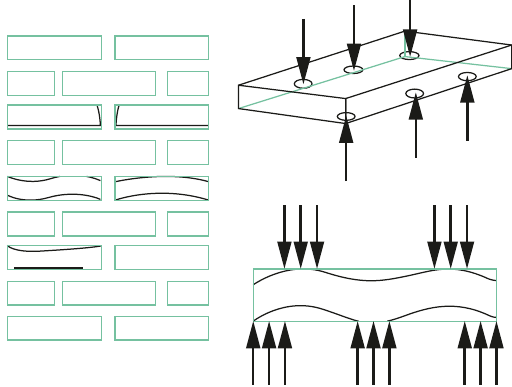
Figure 6: Complex stress state of blocks in masonry structures. Table 5: Flexural strength tests results for HCCSEBs with strength grade MU5.